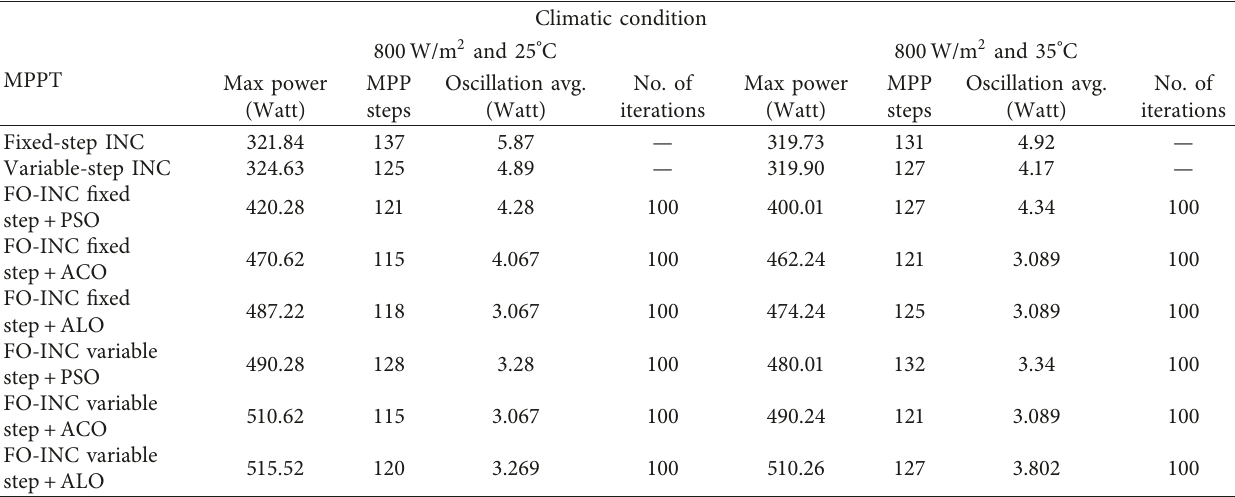
Table 3: Comparative results between MPPT algorithms at 800W/m 2 .